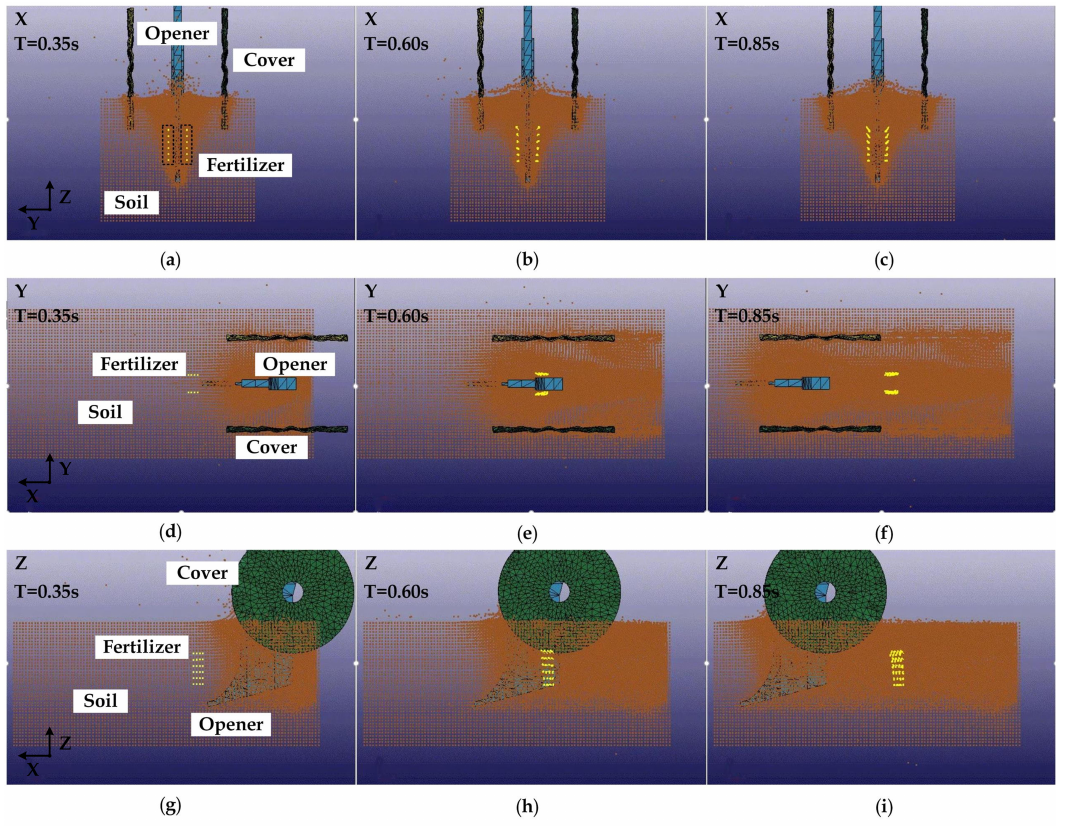
Figure 2. Movement process of the hill-drop fertilizer device, ( a , d , g ) at T = 0.35 s; ( b , e , h ) at T = 0.60 s; and ( c , f , i ) at T = 0.85 s.